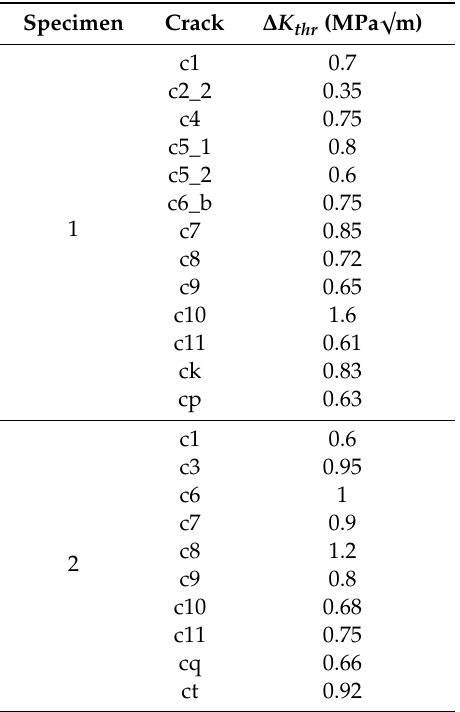
Table 3. Values of the threshold term ( ∆ K thr ) that were used in the